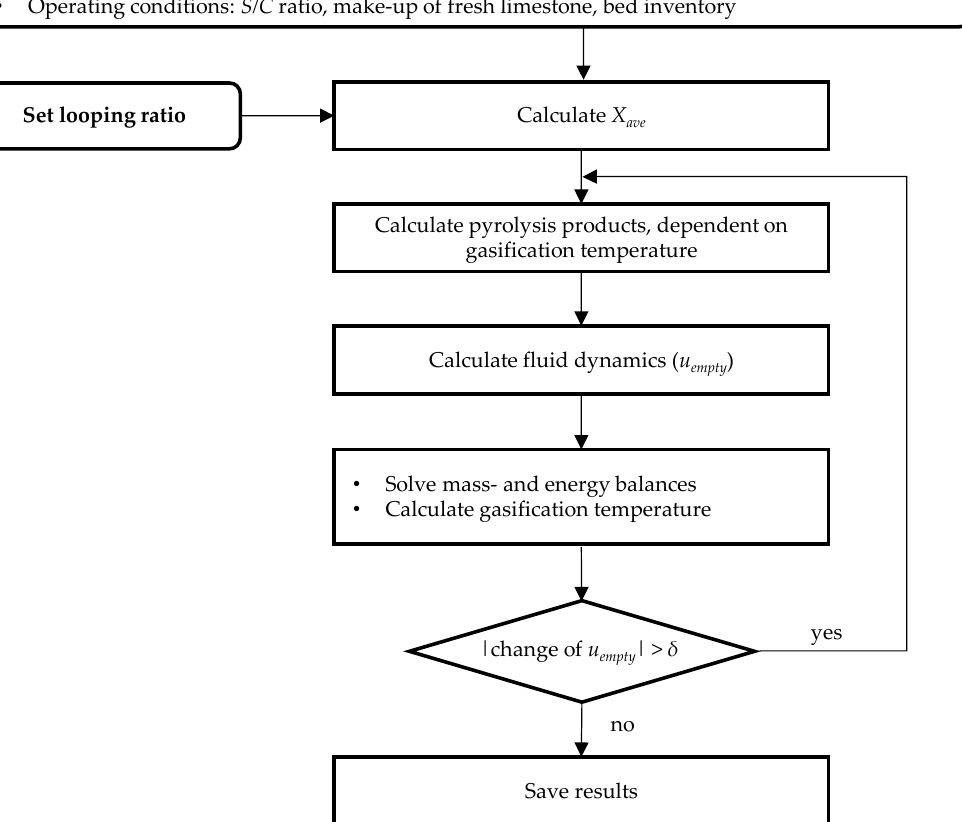
Figure 5. Simulation flow chart for SEG fluidized bed gasifier model.